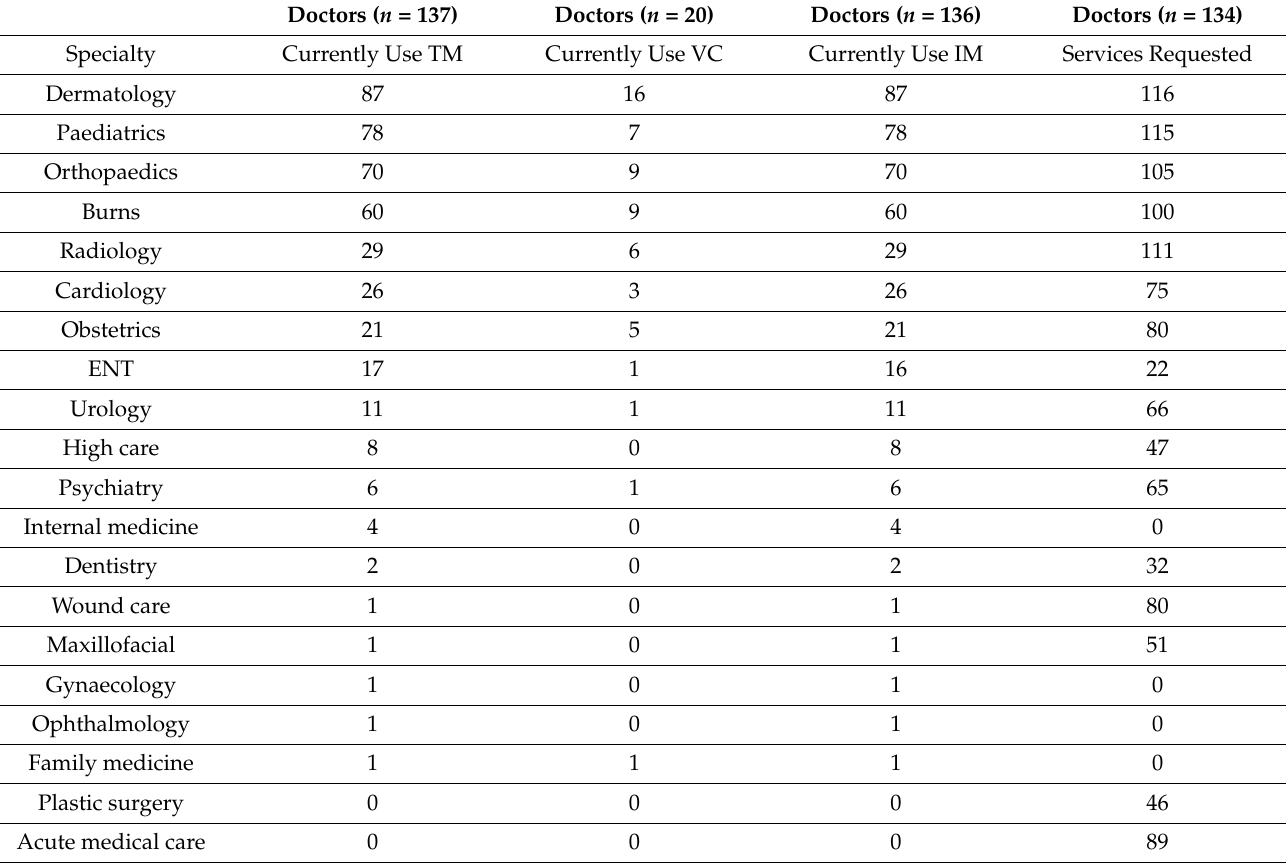
Table 2. Range of specialities for which telemedicine is used, telemedicine mode used, and additional telemedicine services doctors would like to